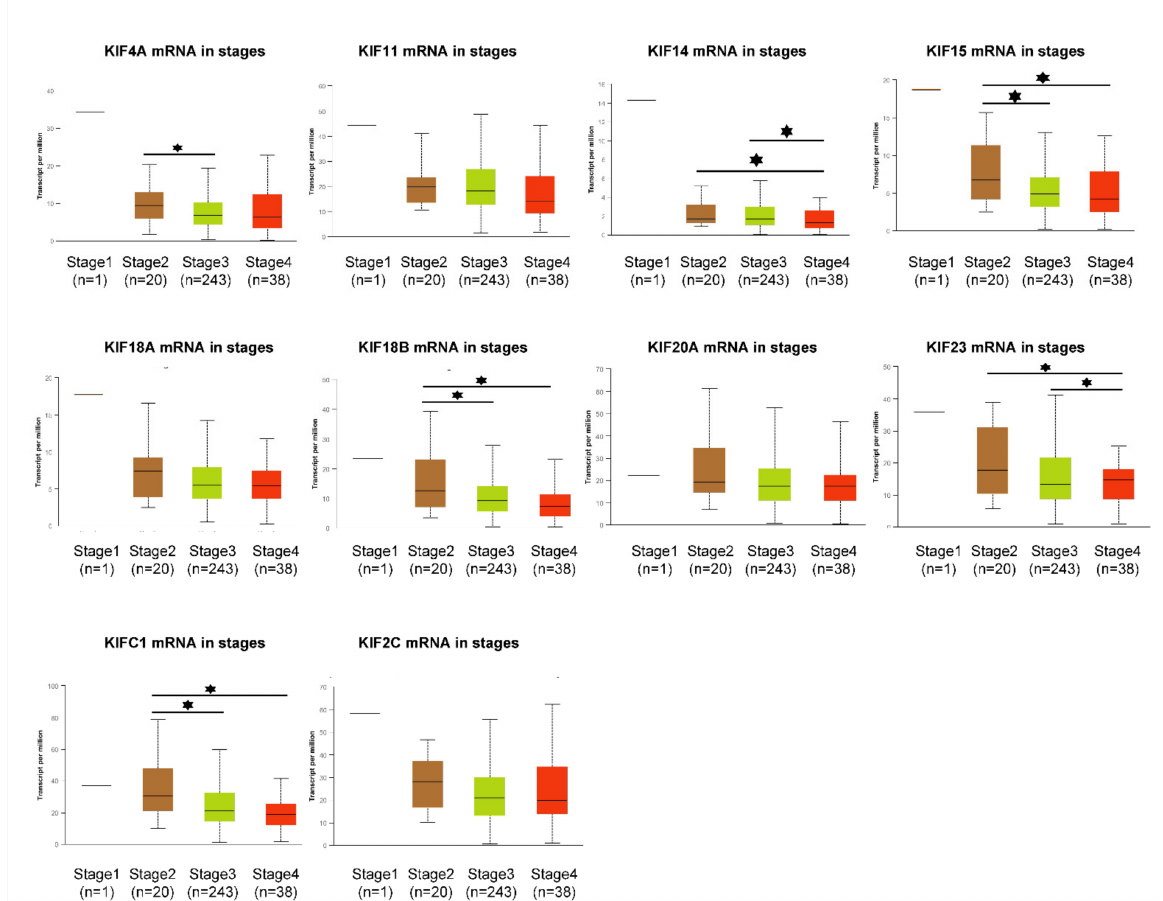
Figure 5. Transcription profiles of ten overexpressed mitotic KIFs in OC clinicopathological subgroup analysis (UALCAN). Sample numbers of each stage: stage 1 ( n = 1); stage 2 ( n = 20); stage 3 ( n = 243); and stage 4 ( n = 38). * p <